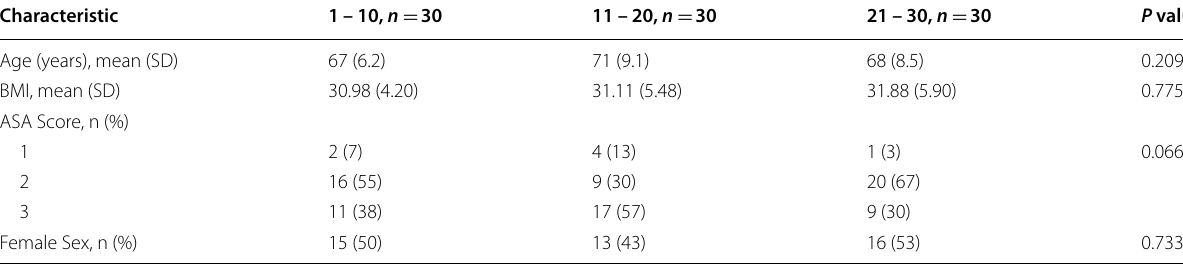
Table 2 Patient characteristics for raTKA groups of ten, all three surgeons combined